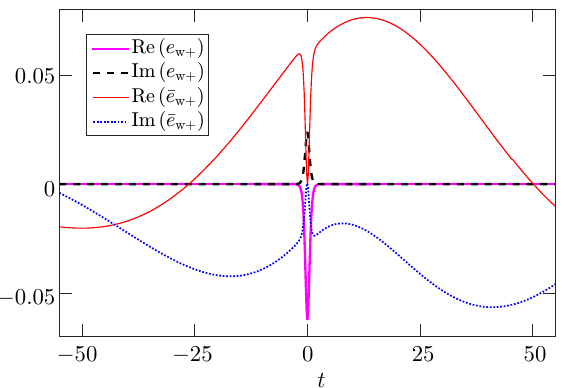
Fig. 4. The variation of the real part of the eigenvalue corre- sponding to the wake modes, where Re( λ w+ ) is derived using the computational method that is described in [62], and λ K is calculated using Eq. (81).